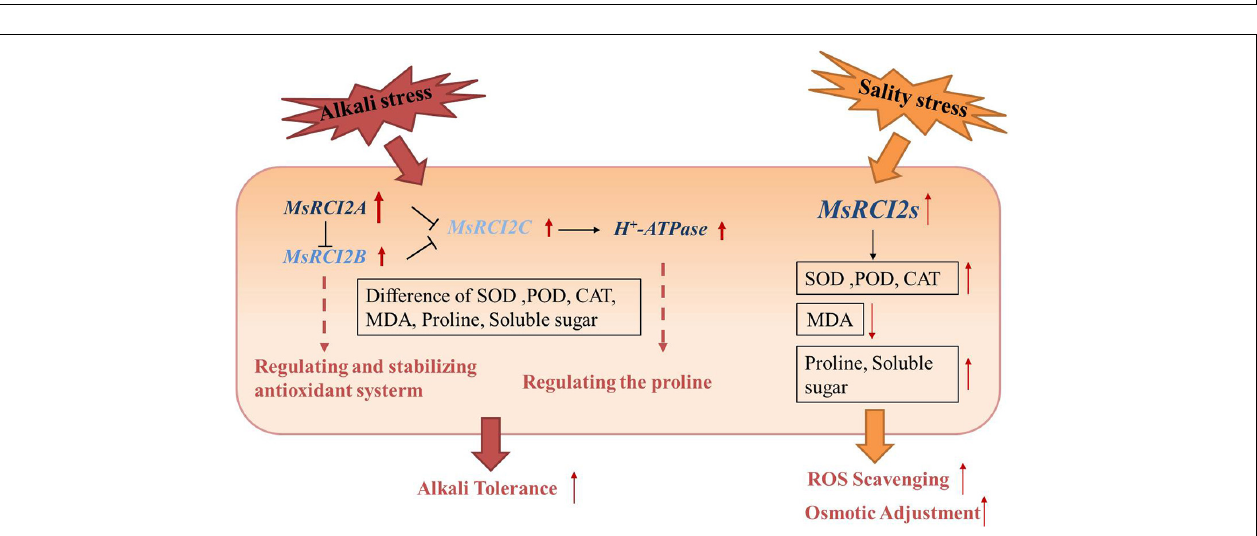
FIGURE 5 | Relative expression of stress-responsive H + - ATPase (A) , MsRCI2A (B) , MsRCI2B (C) , and MsRCI2C (D) genes in WT and transgenic alfalfa plants under alkali stress. The values are the means ± SDs of three replicates (** P < 0.01; * P < 0.05).